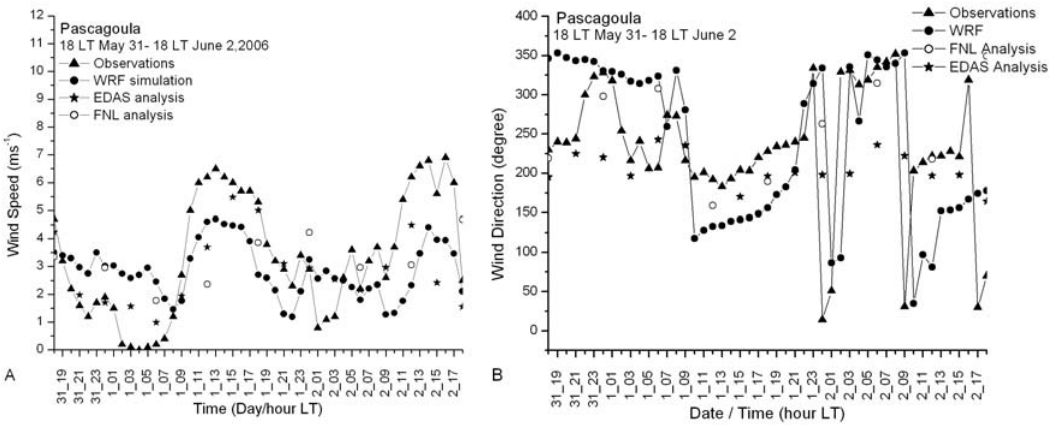
Figure 5. Diurnal pattern of observed and simulated surface (10 m) wind speed (A), wind direction (B) and 2m Air Temperature (C) at Pascagoula station from 00 UTC June 01 – 00 UTC June 02,